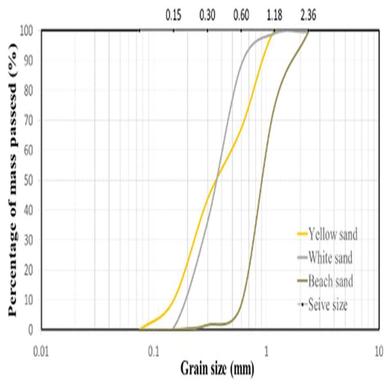
Cumulative curve of the grain size distribution.